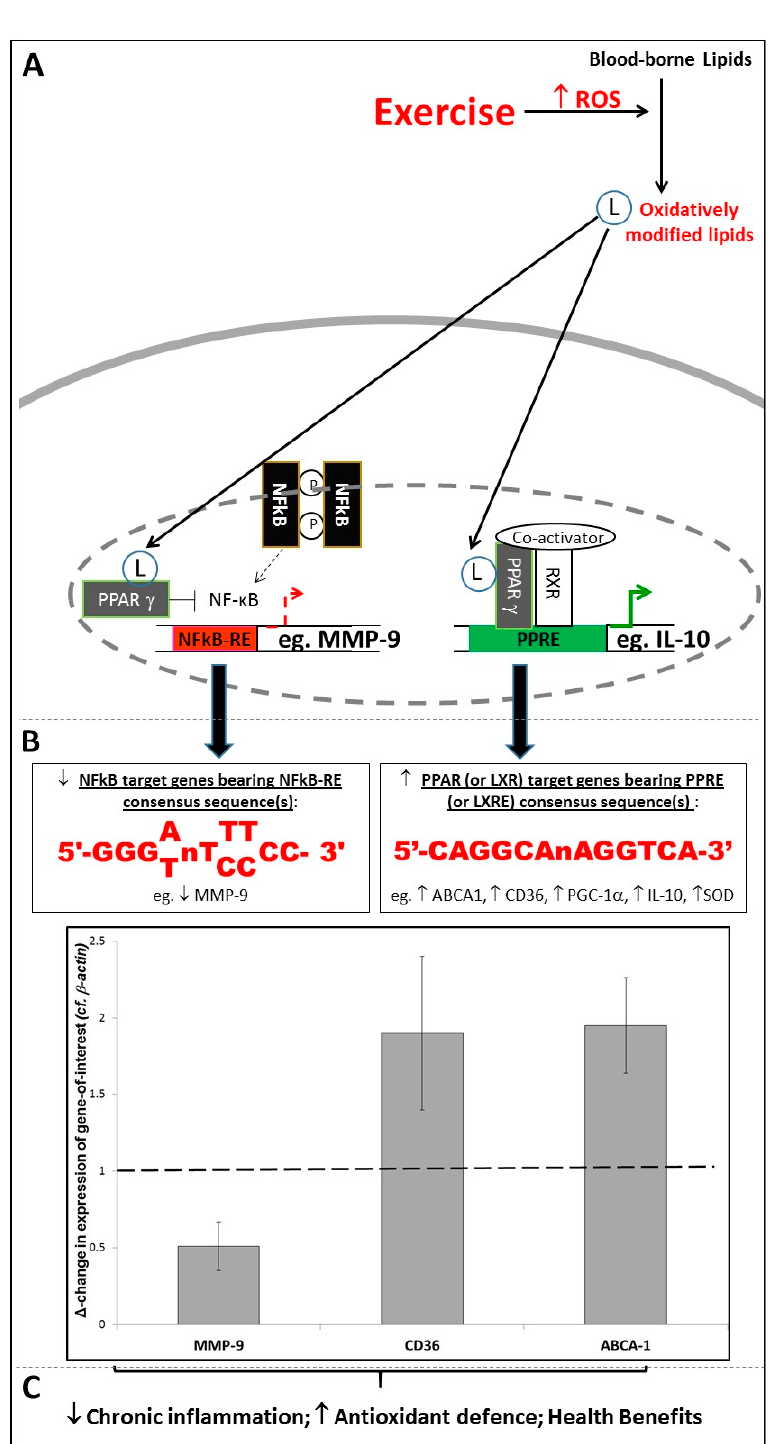
Figure 1. The Role of Response-Elements in Exercise-Associated Redox-Sensitive Signalling Responses. ( A , B ) Exercise triggers oxidative modification of blood-borne lipids, with the resulting modified lipids acting as ligands for transcription factors such as Peroxisome Proliferator Activated Receptor-gamma (PPAR γ ), facilitating (i) enhanced binding of PPAR γ to target genes bearing PPREs/(ii) transrepression of binding of Nuclear Factor-kappaB (NF- κ B) to target genes bearing NF- κ B-REs; ( C ) As a result, PPAR γ target genes are upregulated, and NF- κ B target genes are downregulated, following exercise; the graph shows RT-PCR data (Mean ± SEM) showing significant downregulation of MMP-9 mRNA, and upregulation of CD36 and ABCA1 mRNA, following completion of an 8-week exercise programme ( n = 22; p < 0.05 in all cases). (RT-PCR data are adapted from Webb et al., 2016 [56]) .